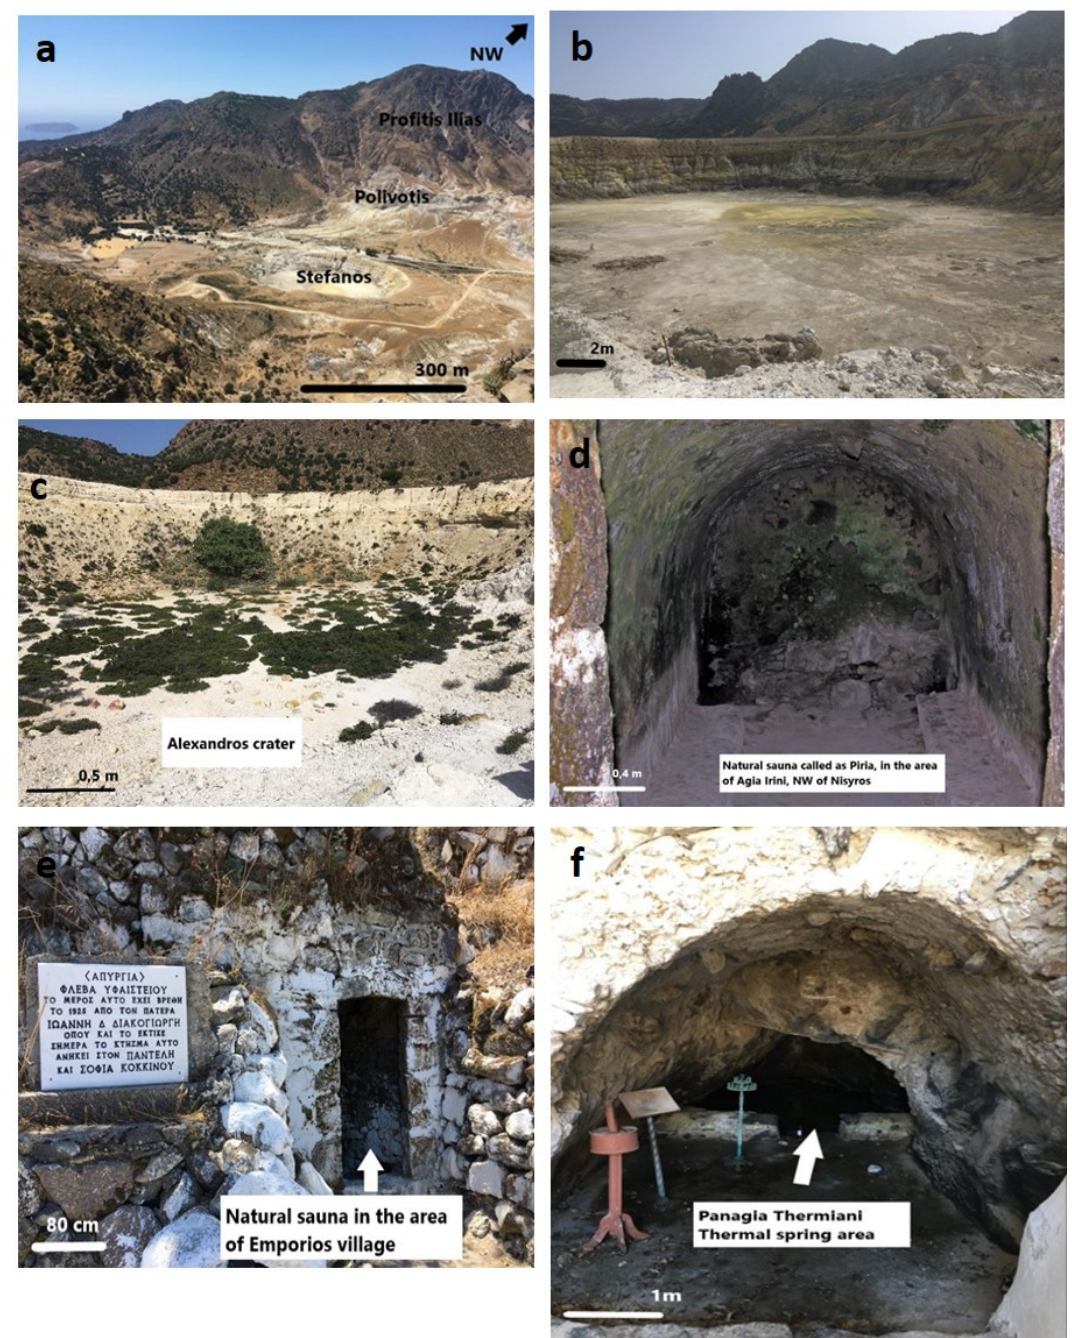
Figure 8. Geosites of Nisyros Island: ( a ) the Stefanos and Polyvotis craters, ( b ) the Stefanos crater, ( c ) the Alexandros crater, ( d ) the Piria hot spring, ( e ) natural hot spring of Emporios, and ( f ) Panagia Thermiani thermal spring.